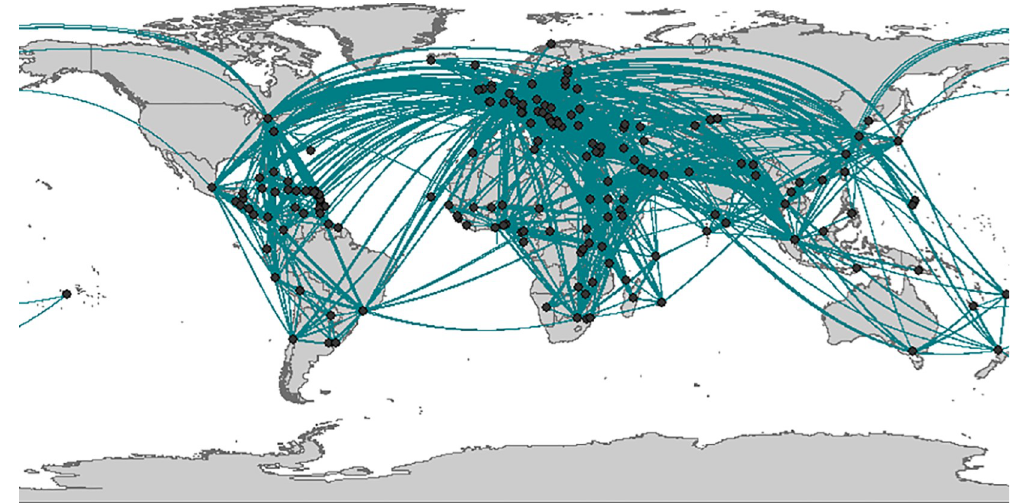
Fig 3. The airport network of the COVID-19 arrival